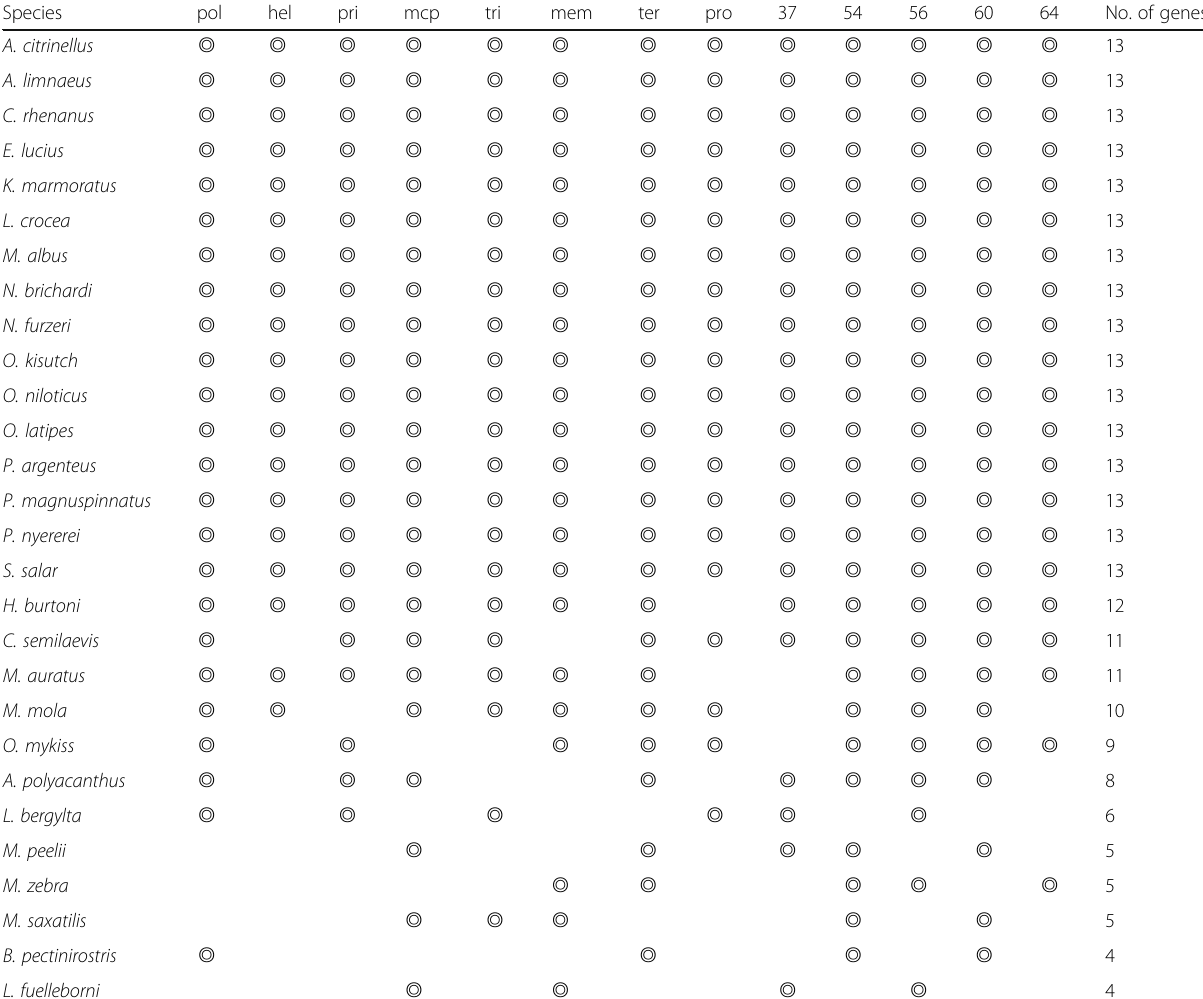
Table 1 tblastn of alloherpesvirus core genes of medaka Teratorn against teleost genomes